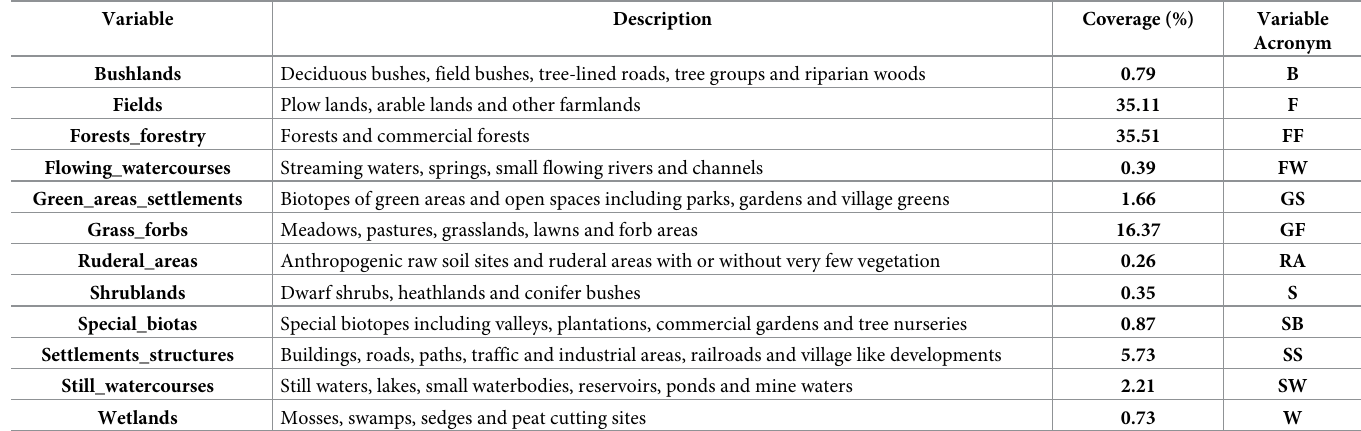
Table 1. Distance to edge-based land-use variables (DELVs) used as predictors in the Federal State of Brandenburg, Germany.